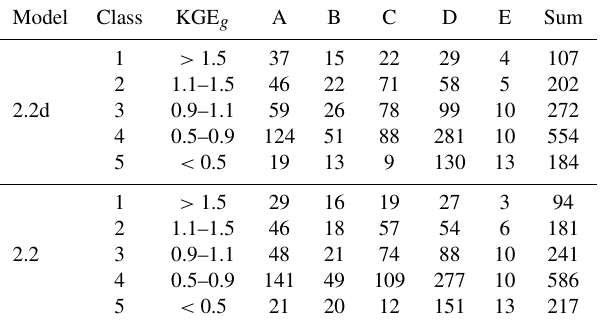
Table 5. Model performance with respect to streamflow variabil- ity: number of calibration basins per KGE g category and Köppen– Geiger climate